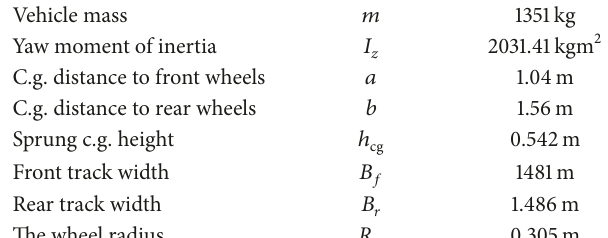
Table 1: Vehicle parameters.